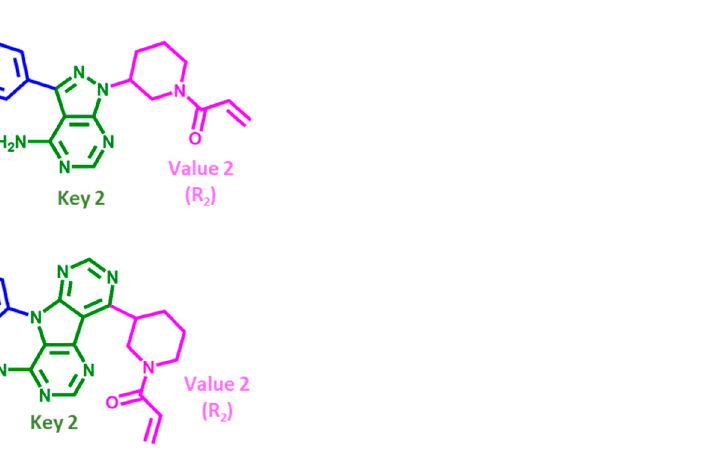
Figure 2. Key 2, Value 2, and Value 1 fragment assembly. Shown is the DeepSARM fragment composition of ( a ) ibrutinib and ( b ) a candidate compound. Key 2, Value 2 (R 2 ), and Value 1 (R 1 ) are displayed in green, magenta, and blue, respectively.